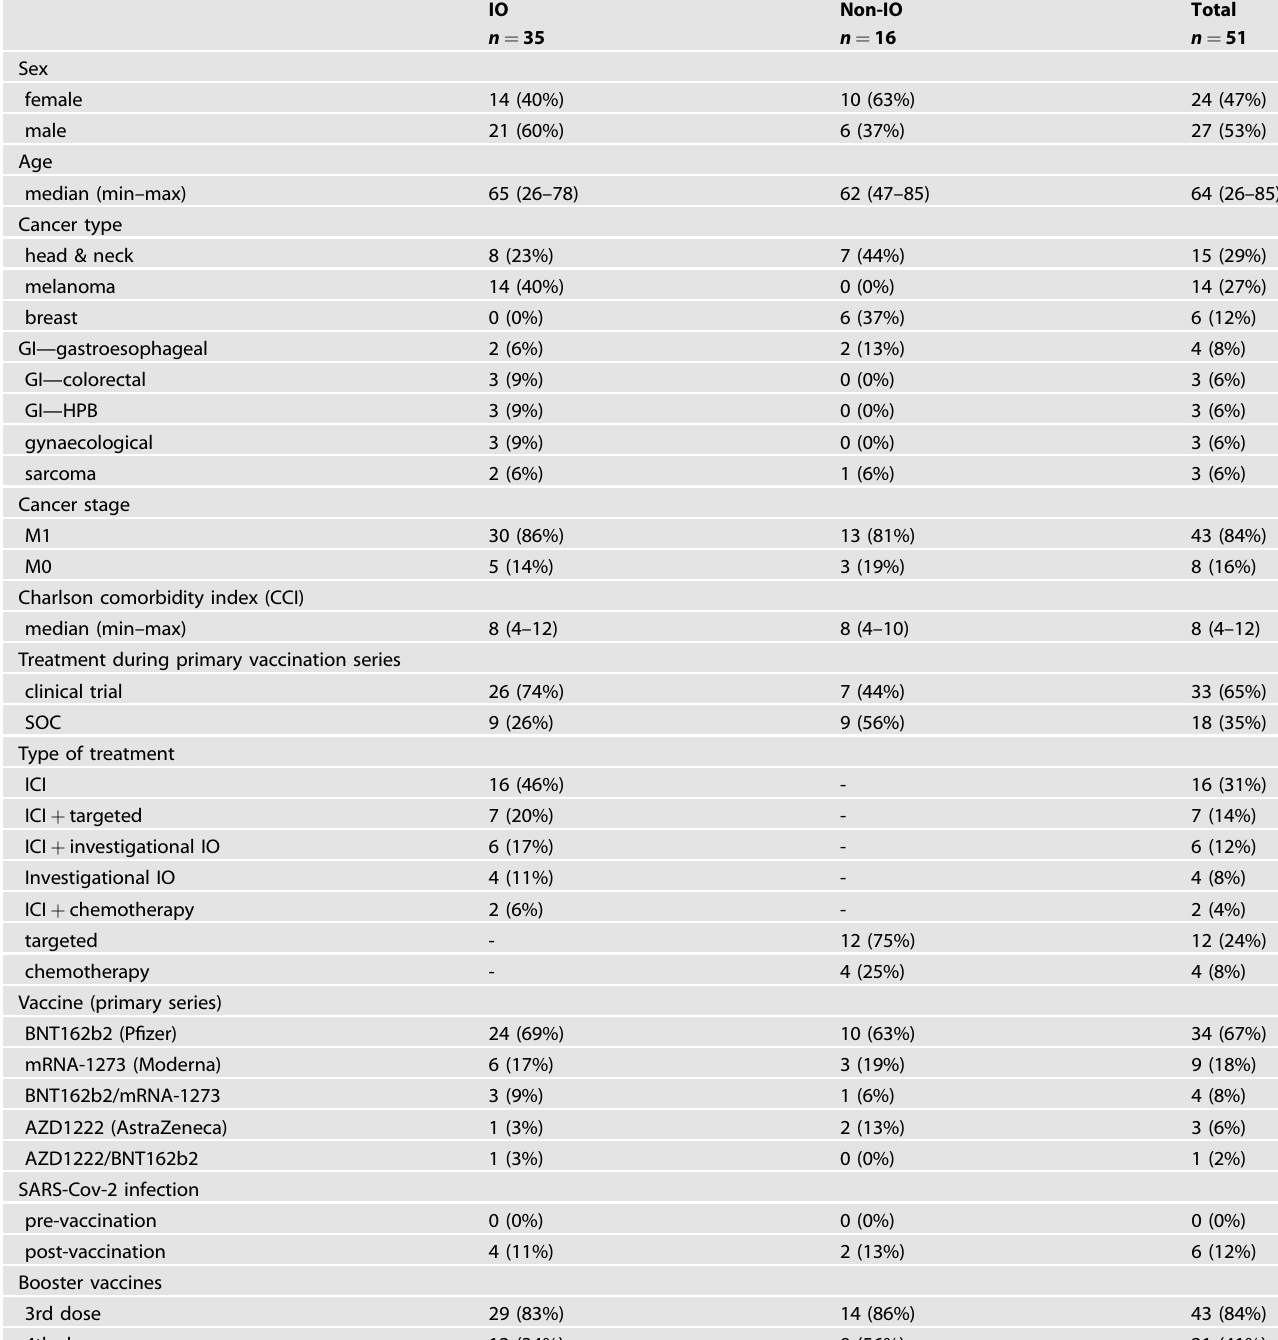
Table 1. Patients characteristics at